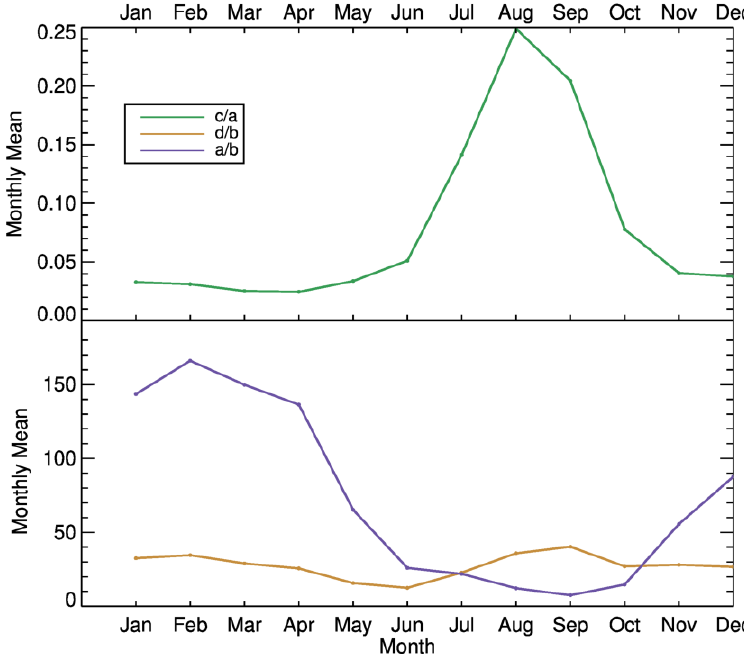
Figure 8. Monthly mean values of a , b , c , and d in the contingency table when AMSR2 ice and water identification are compared to IMS ice and water identification over the Peripheral Seas of the Arctic Ocean.